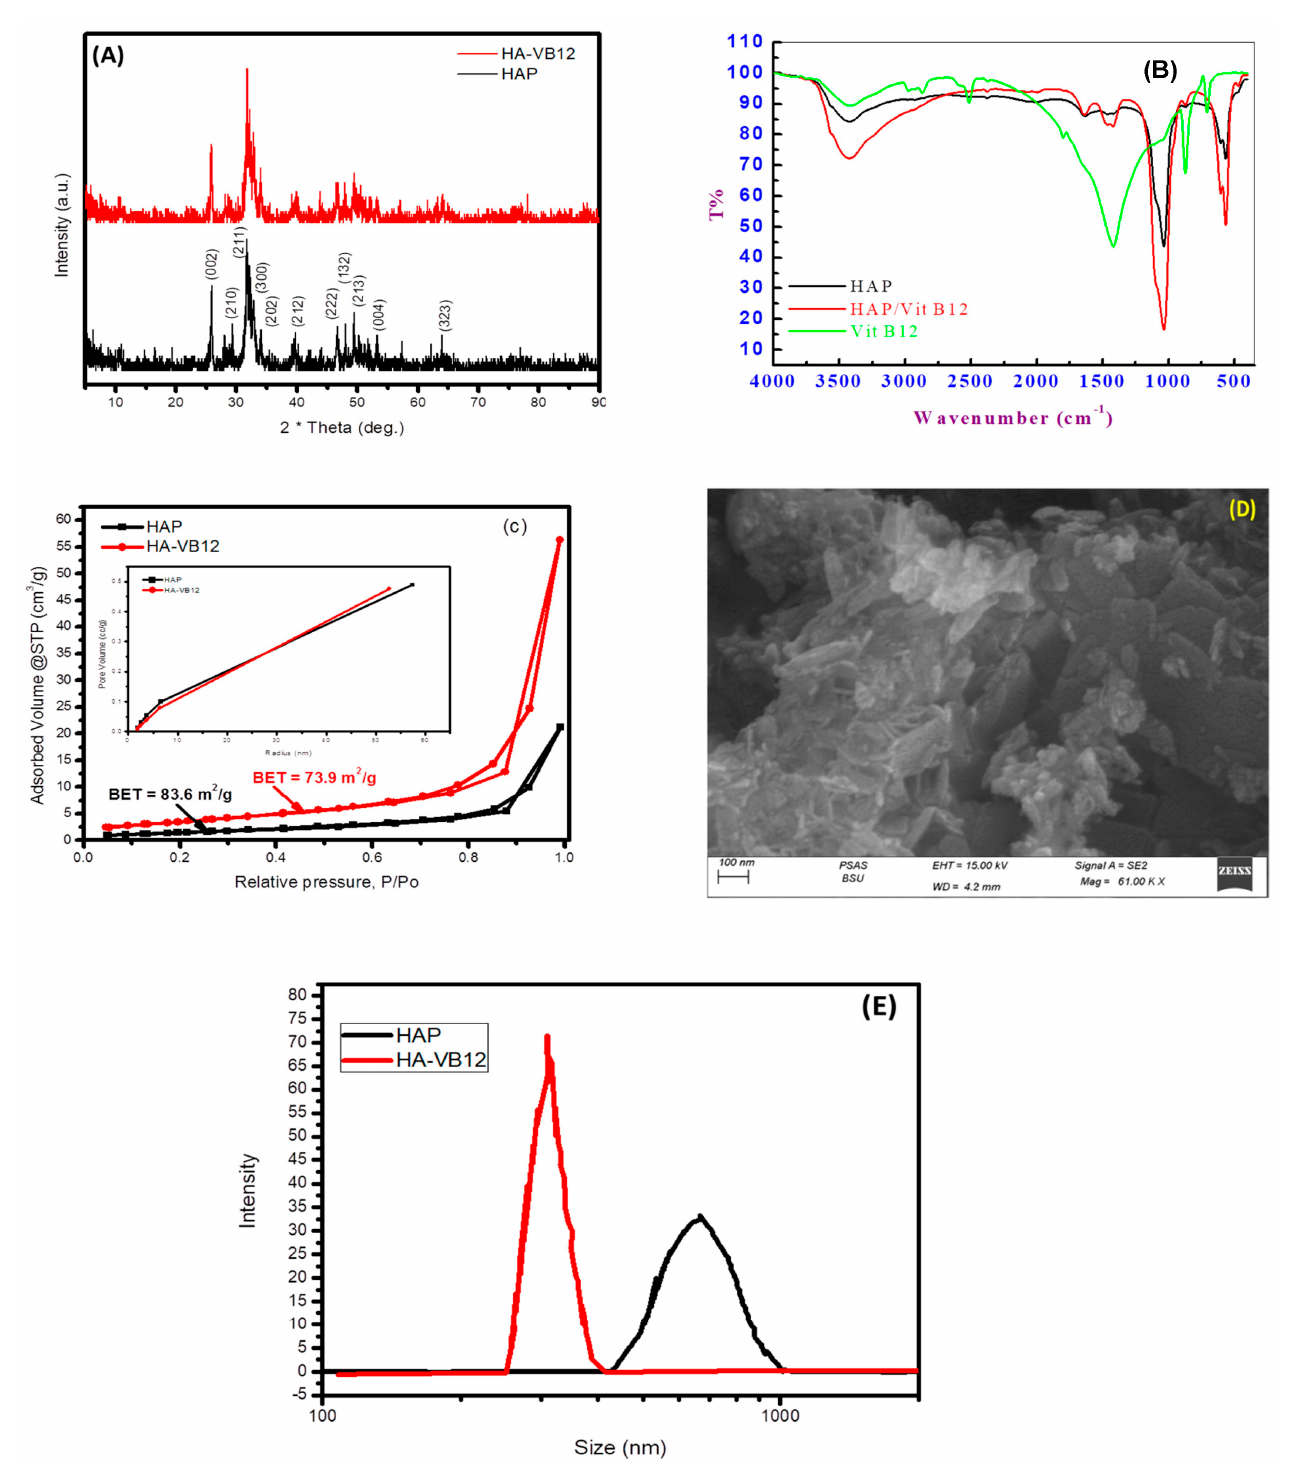
Figure 1. ( A ) XRD; ( B ) FTIR; ( C ) N 2 adsorption–desorption isotherm (inset: BJH pore size